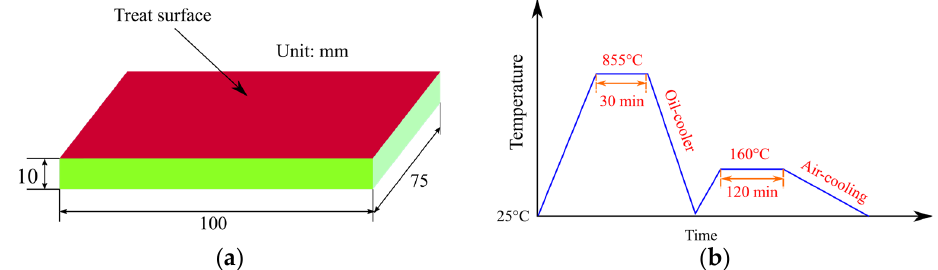
Figure 1. ( a ) The geometric parameters of samples; ( b ) the heating process.